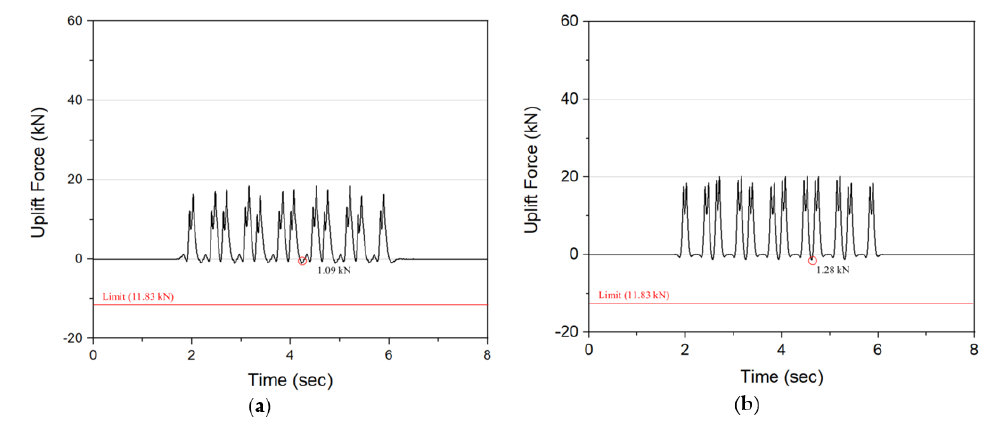
Figure 9. Rail Uplift Force results: ( a ) Type I, ( b ) Type II.